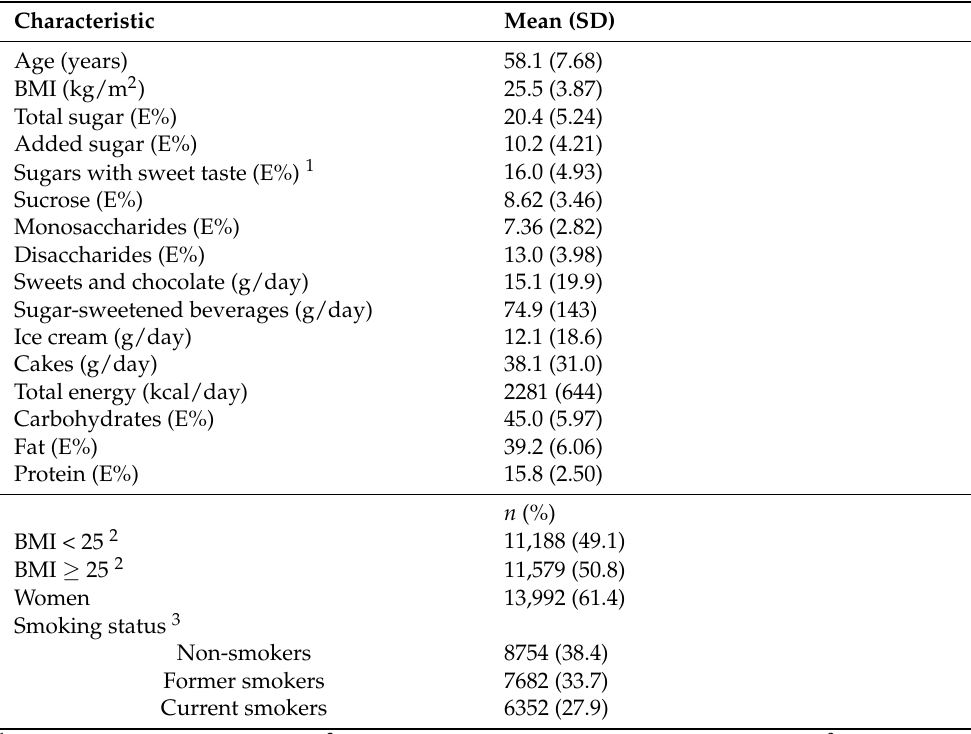
Table 1. Baseline characteristics for the Malmö Diet and Cancer study population.